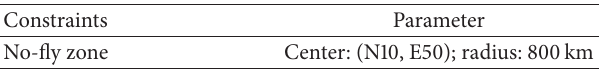
Table 9: Parameters of the geographic constraints (Case 3).